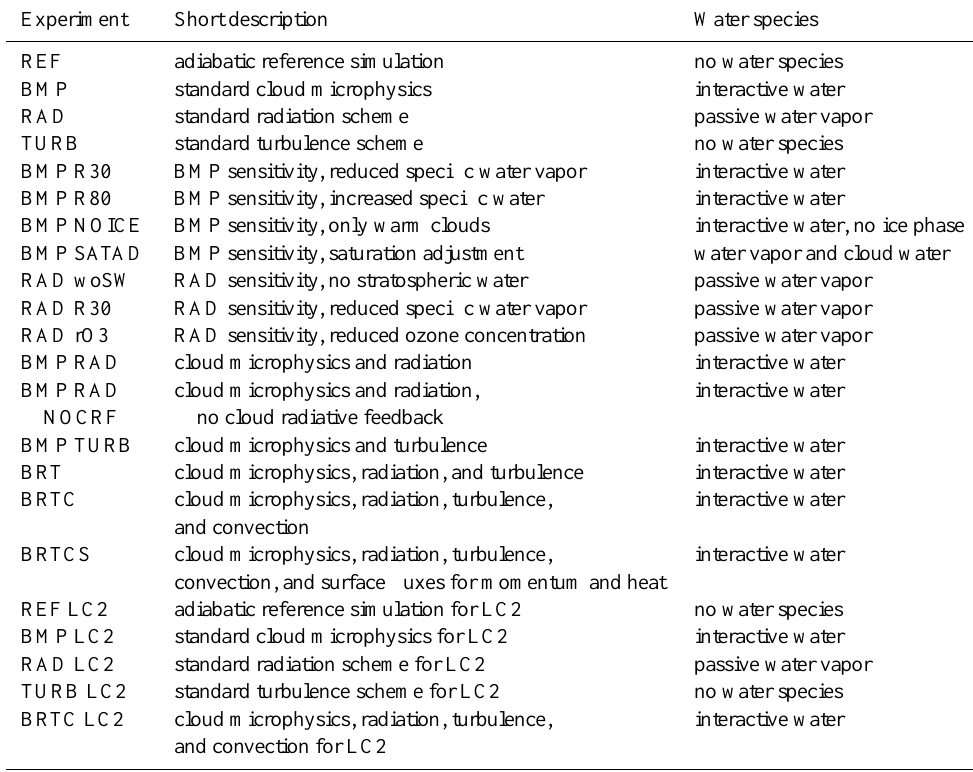
Table 1. Summary of experiment acronyms, description, and water treatment Experiment Short description